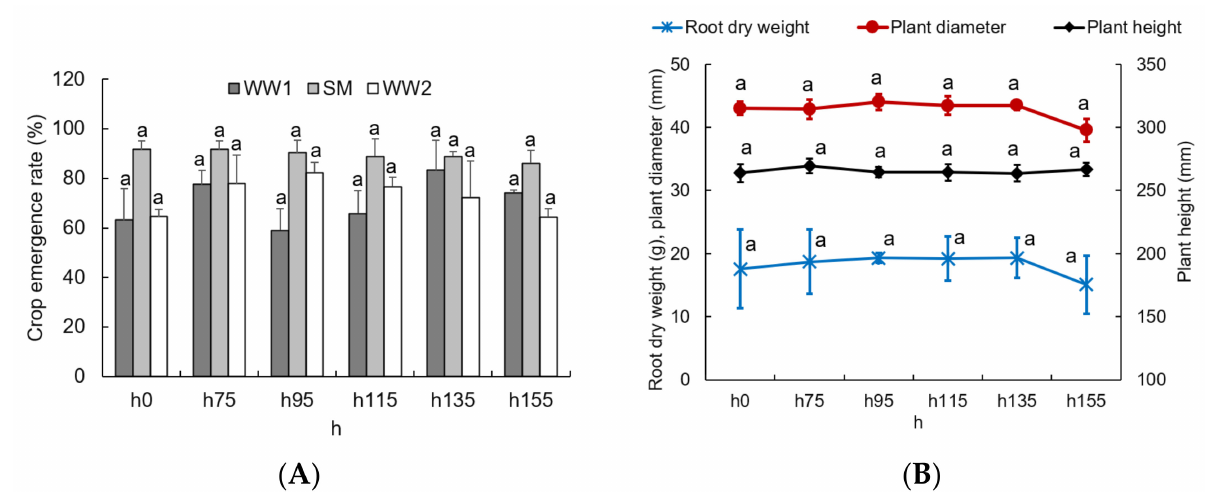
Figure 8. Effect of wing mounting height (h) on crop emergence rate ( A ) and maize growth condition ( B ). (Same letters (a) mean no significant difference at p > 0.1; WW1 and WW2 stand for winter wheat in the first and second growing seasons, respectively; error bars represent standard deviations from the